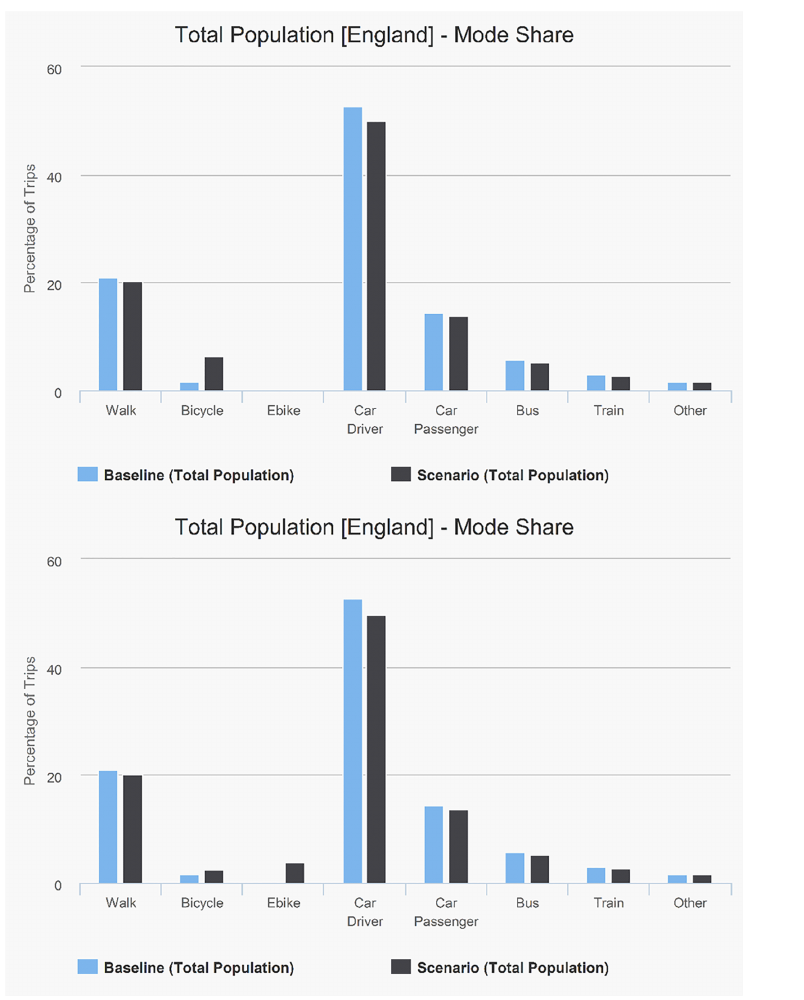
Fig 5. Mode share baseline compared with scenario 25%, equity off, e-bike